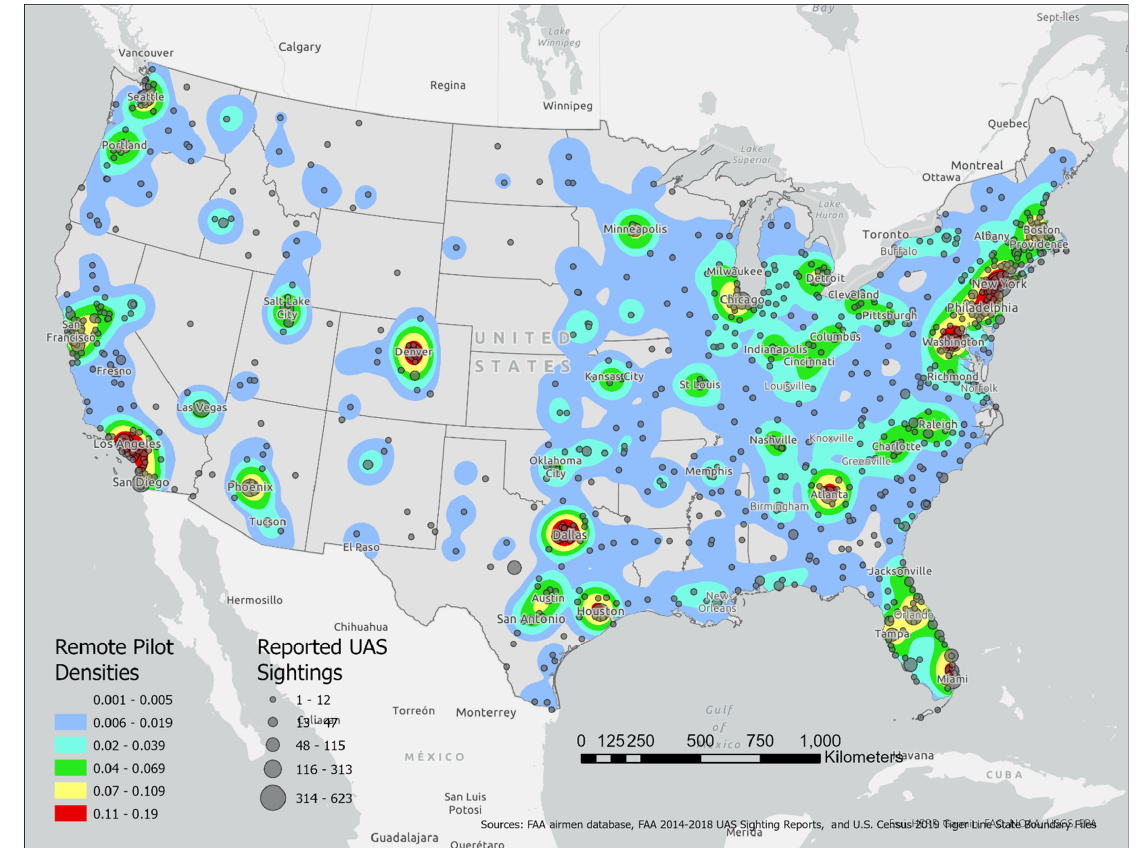
Figure 8. UAS sighting report frequencies from 2014 to 2018 geocoded at the city level compared to 2019 remote pilot registration densities.